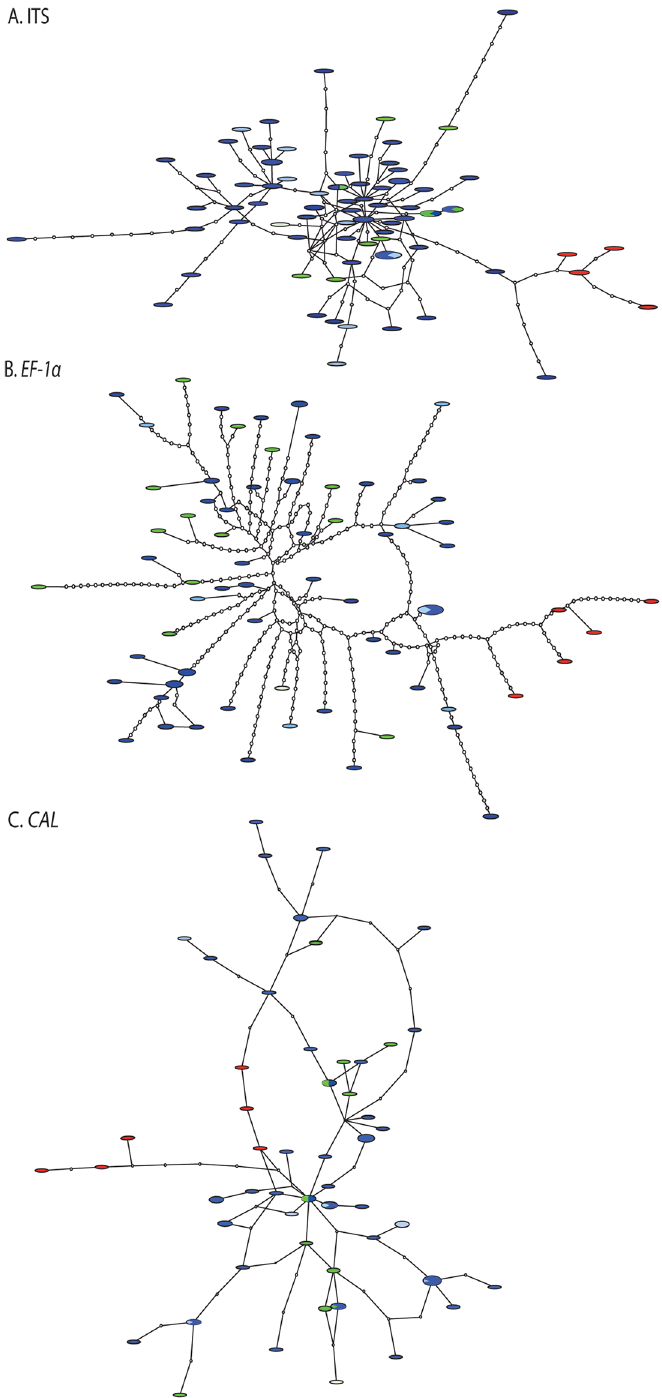
Fig 2. Multilocus haplotype networks (92% criterion) of Exobasidium maculosum isolates constructed in TCS v1.21 (32) for the loci A. ITS, B. EF-1 α , C. CAL . Each haplotype is represented as a circle proportional in size to the number of isolates in each haplotype. Inferred intermediate haplotypes are represented by a small solid dot. Each line segment represents a single mutation. The number of isolates in each haplotype collected from Georgia (blue) and North Carolina (green) and leaf (dark color shades) and fruit (light color shades) plant tissue are proportionally represented in pie charts. Haplotypes in red represent isolates from northeastern North